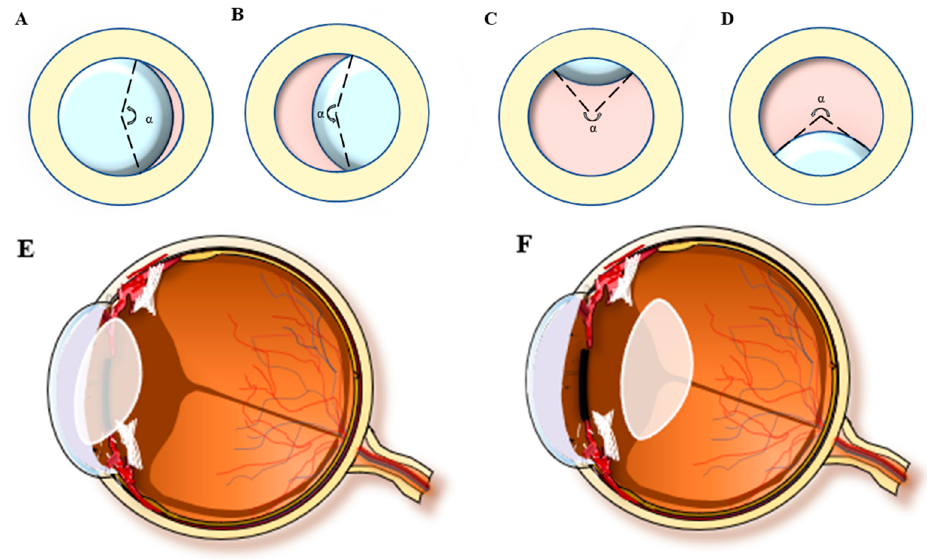
Figure 1. Lens dislocation direction and the representation of curvature degree (angle α ): take the left eye of the opposite patient as an example. ( A ) Nasal direction, ( B ) Temporal direction, ( C ) Superior direction, ( D ) inferior direction, ( E ) Anterior direction, ( F ) Posterior direction.